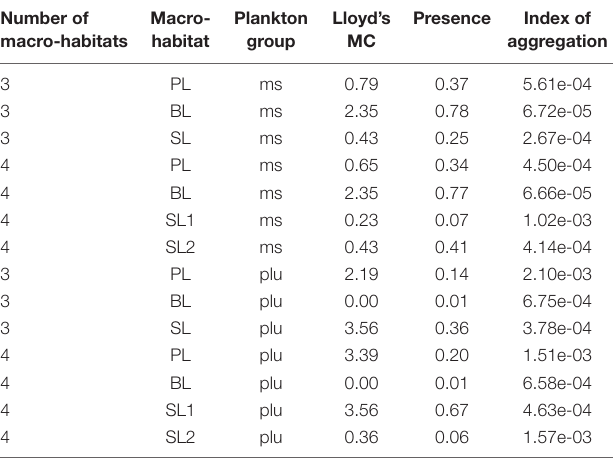
TABLE 2 | Lloyd’s mean crowding and Bez’s Index of aggregation for 3 and 4 segregated macro-habitats for transect T2 (HE429). Number of macro-habitats